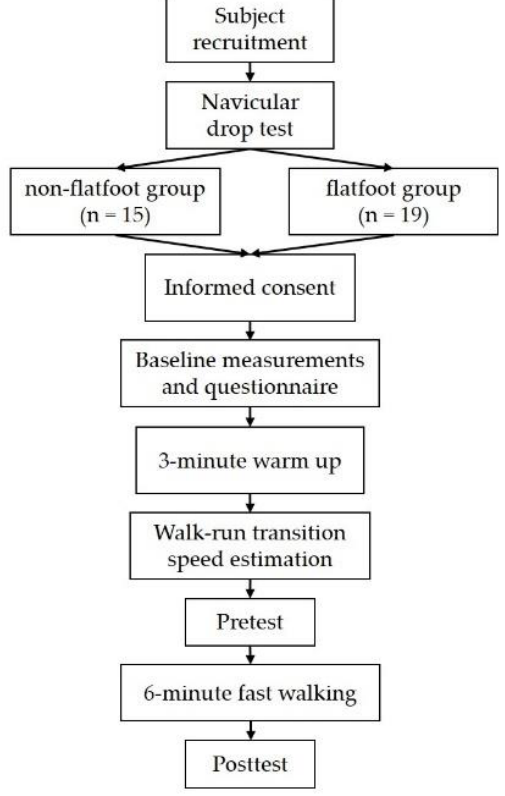
Figure 1. Study Figure 1. Study flowchart.